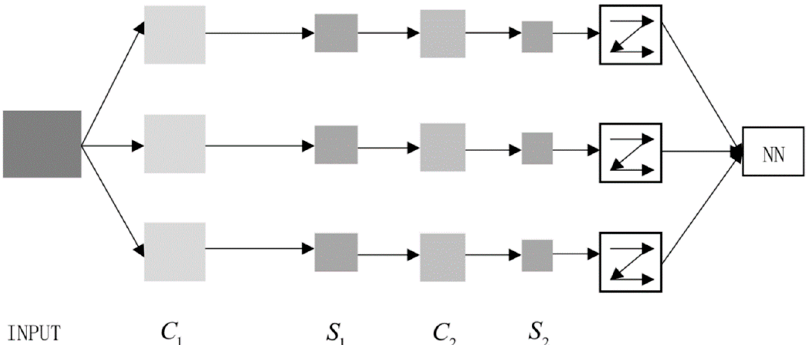
Figure 2. Convolutional neural network (NN) structure. C is convolution and S is down-sampling.